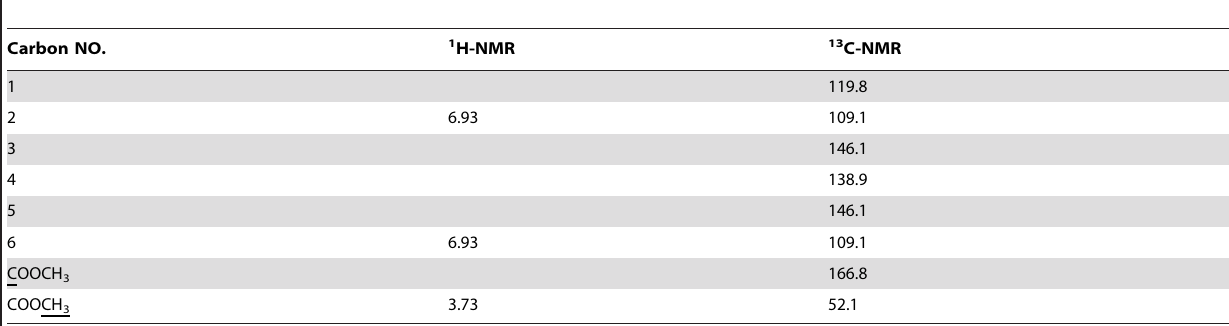
Table 1. 1 H- and 13 C-NMR spectral data of compound 1 (methyl gallate) isolated from Galla Rhois .